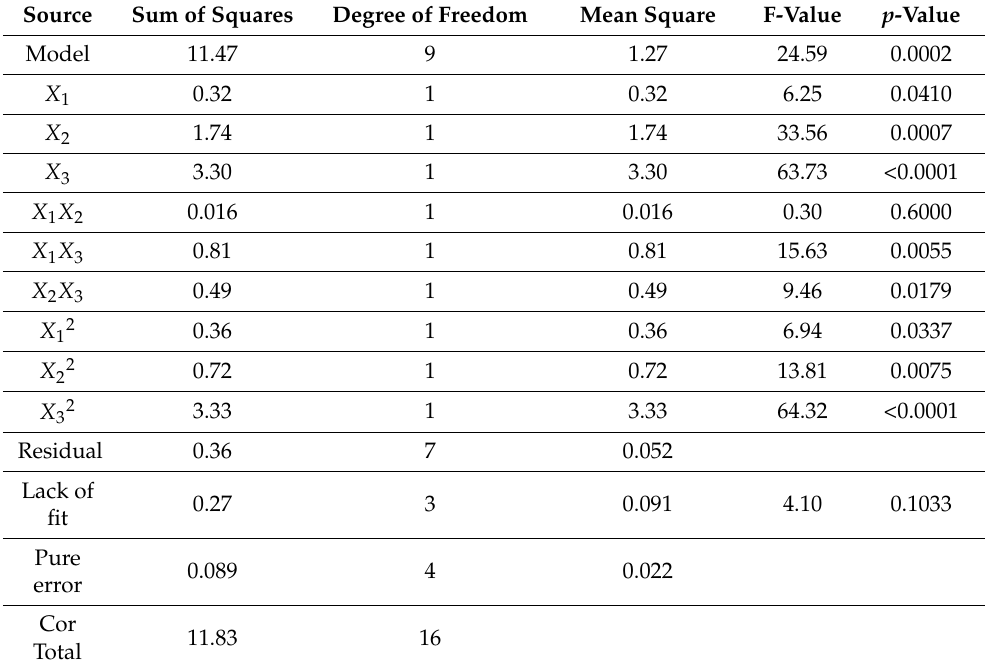
Table 4. Regression analysis of variance of Y 1 .